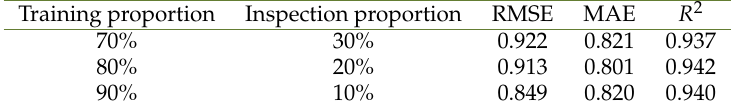
Table 5. The results of different data training ratios and test